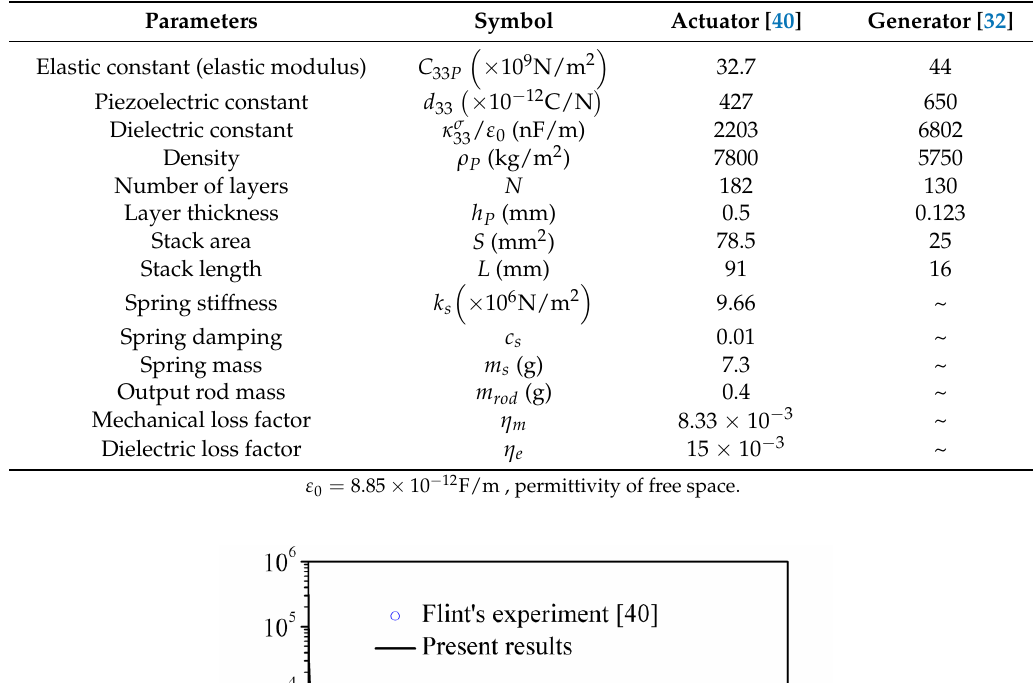
Table 1. Geometric and material parameters of the piezoelectric stack.